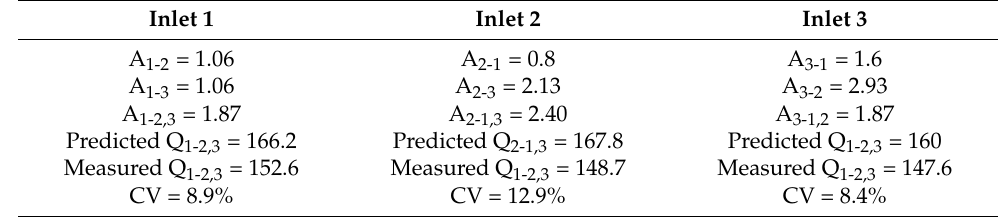
Table 1. Calculated model values for gravity-driven aqueous flow. The predicted flow rate values were compared experimental values and the coefficient of variance (CV) was calculated for each